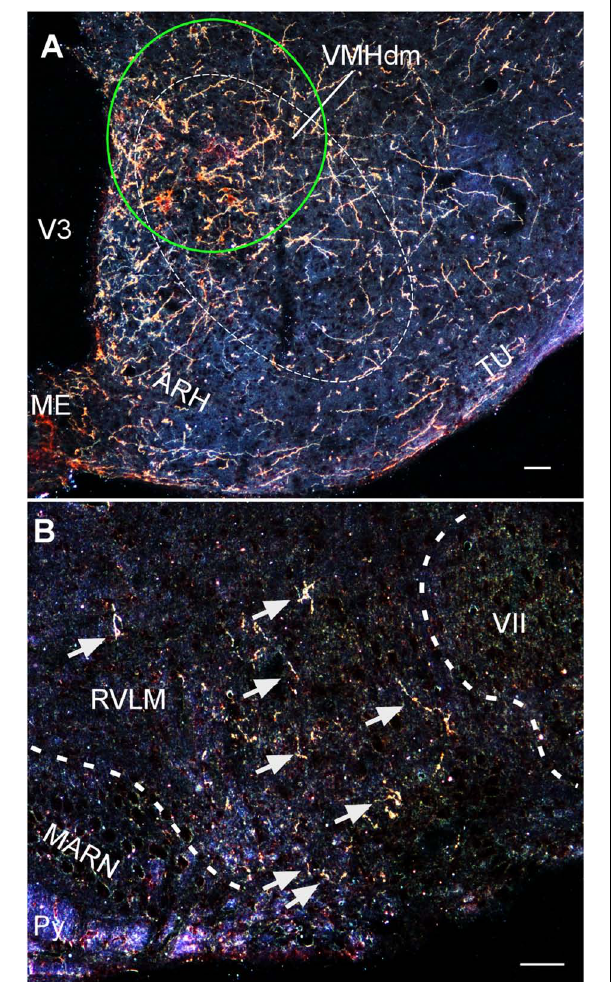
FIGURE 3 | (A) Darkfield photomicrograph showing the injection site (green circle) of an adenoviral vector encoding Cre-regulated expression of farnesylated green fluorescent protein (GFP f ) delivered into theVMH of a CRFR2-Cre mouse.The expression of GFP f is normally silenced due to a Cre-regulated transcription block sequence inserted upstream of GFP f reporter cassette. In the presence of Cre, the transcription block sequence is removed to allow GFP f to be expressed in Cre-positive cells. (B) Darkfield photomicrograph depicting the distribution ofVMH CRFR2-positive fibers (golden staining) within the rostral ventrolateral medulla (RVLM). ARH, arcuate nucleus of hypothalamus; MARN, magnocellular reticular nucleus; ME, median eminence; Py, pyramidal tract;Tu, tuberal nucleus;V3, third ventricle;VII, facial nucleus;VMHdn, dorsomedial part of the ventromedial nucleus of hypothalamus. Scale bar = 50 μ